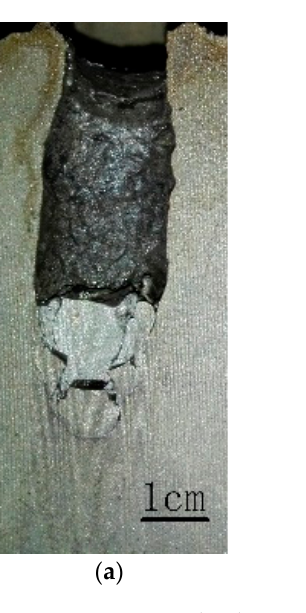
Figure 4. Longitudinal sections of craters penetrated by WF/Zr-MG rods. ( a ) v = 1560 m/s; ( b ) v = 1523 m/s.